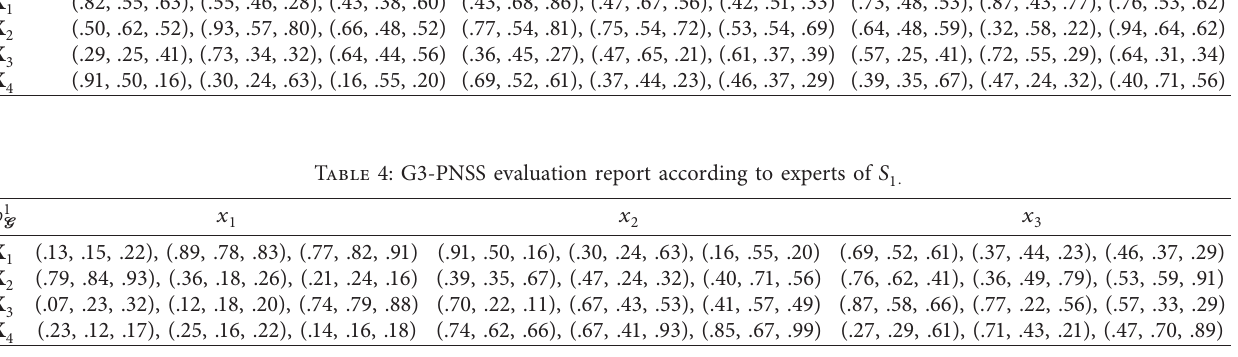
Table 5: G3-PNSS evaluation report according to experts of S